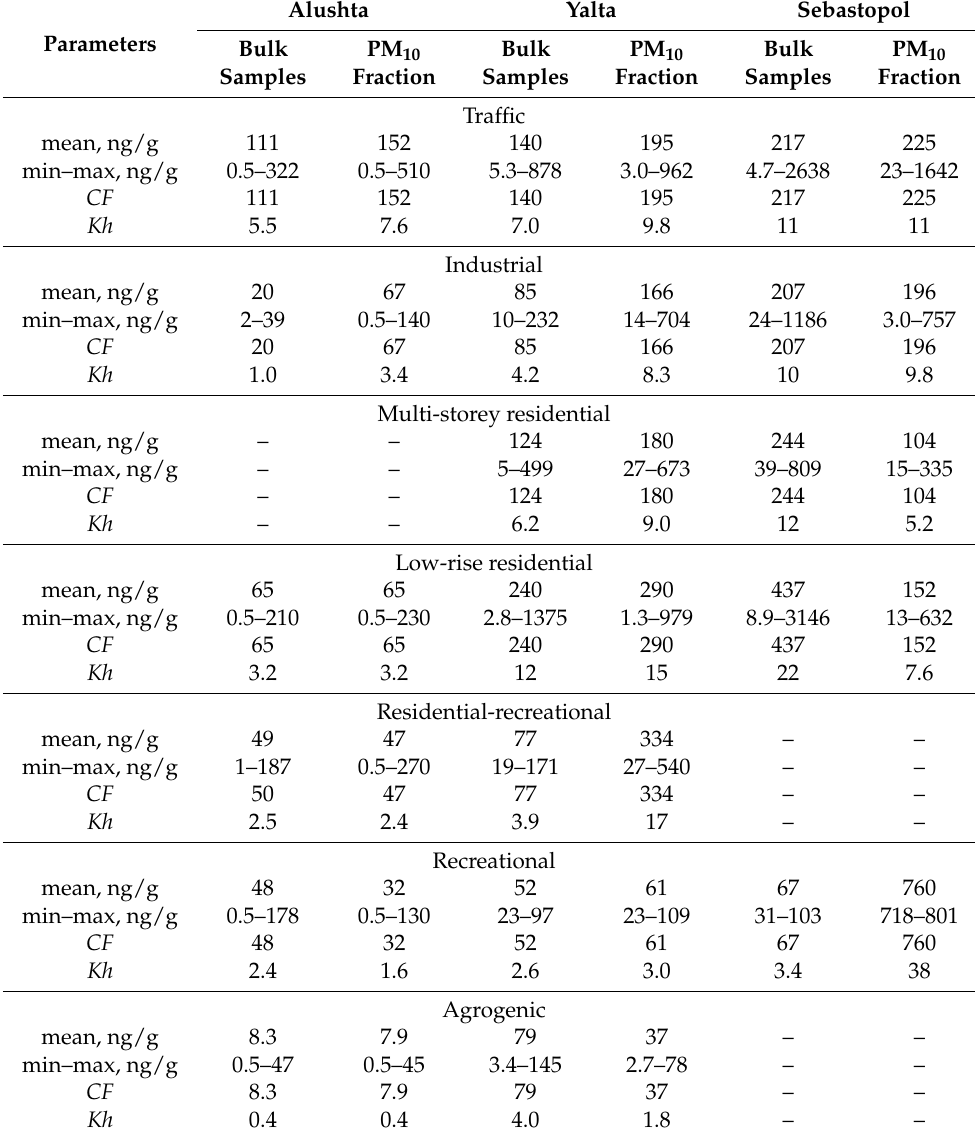
Table 1. The content of benzo(a)pyrene in urban soils and their PM 10 fraction of land use zones in Alushta, Yalta, and Sebastopol. Alushta Yalta Sebastopol Parameters Bulk PM 10 Samples